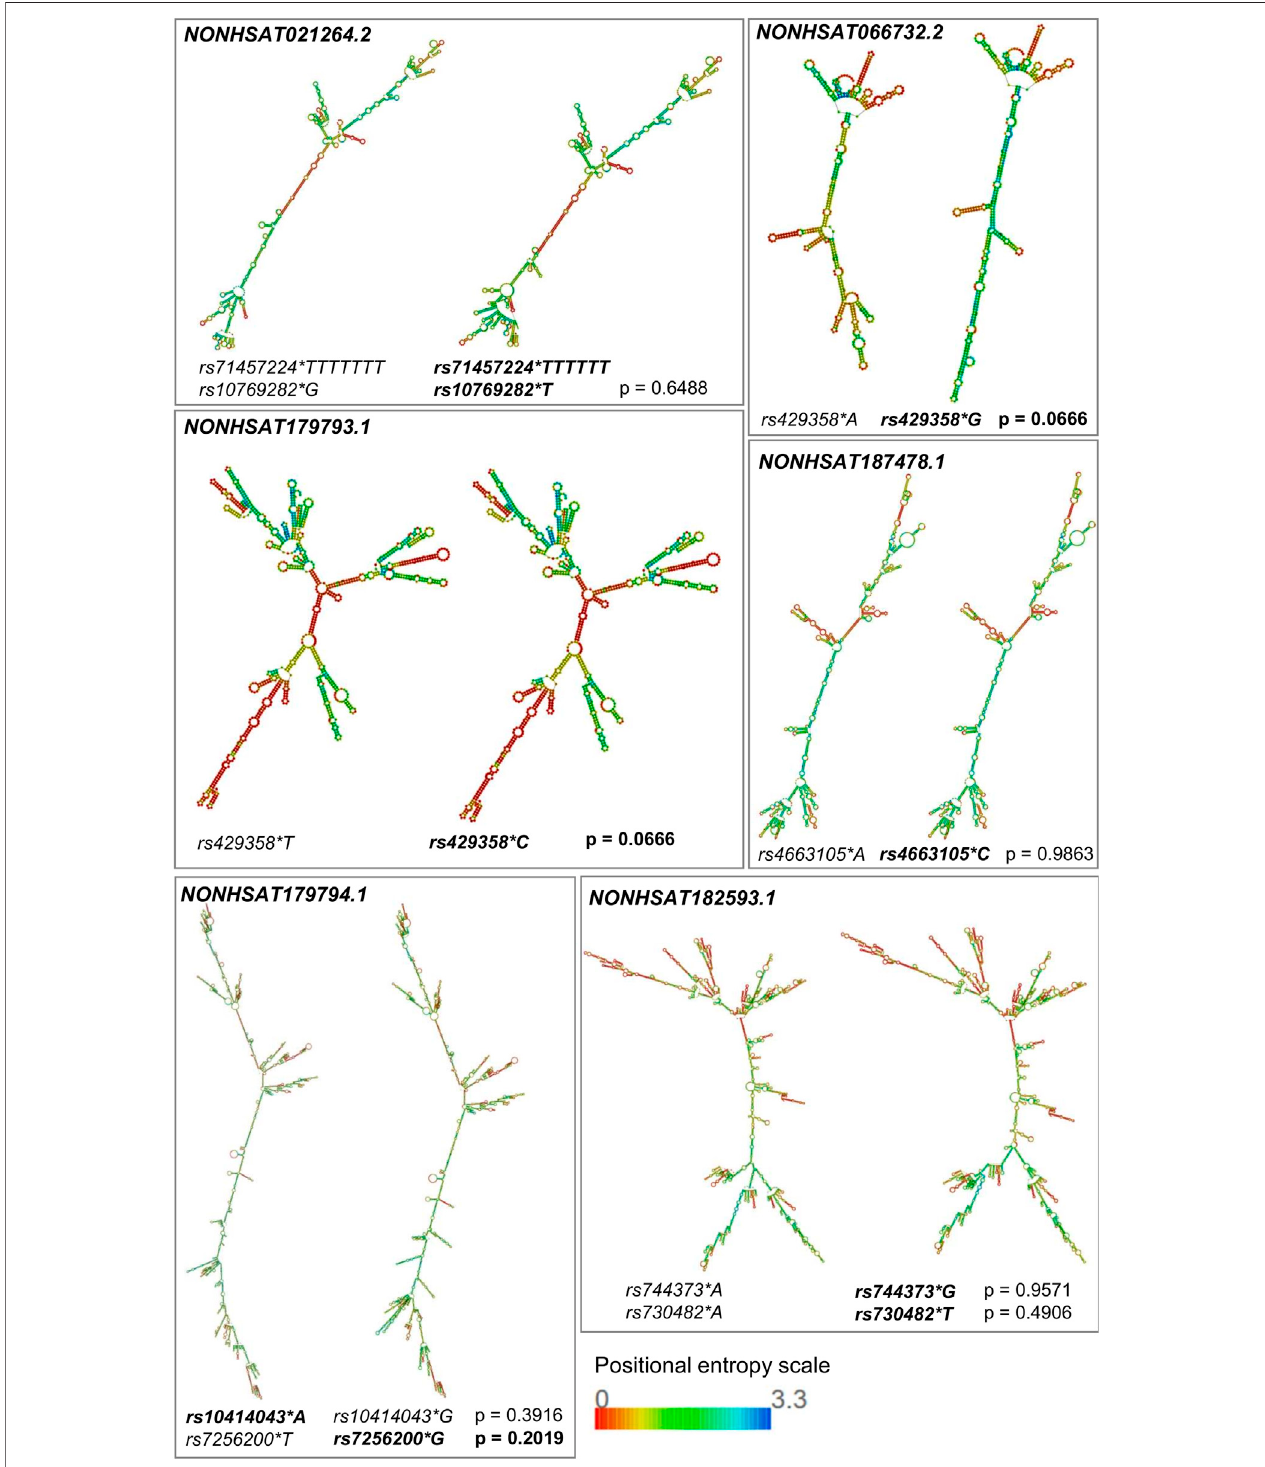
FIGURE 2 | Prediction of secondary structures of lncRNAs possibly involved in AD. The secondary structures of the lncRNAs possibly involved in AD were predicted by the RNAfold web server based on the Vienna RNA package, considering the calculation of minimum free energy (MFE) and positional entropy. Structures were generated for both alleles (alleles in bold are deemed to have a possible harmful role). The impact of these mutations on the structures was established by visually changingthemoleculeandthe p -valueprovidedbylncRNASNP2.This p -valueisempirical,beinggenerated insilico ,throughtheSNP ’ sposition,theGCcontentof the molecule, and thesizeofthesequence ( p < 0.2 (cid:1) possibly harmful).Within the positional entropy scale, lowentropy(red) leadstolittlestructural fl exibility,making the prediction more reliable, while regions of high entropy (violet) may have several alternative structures.